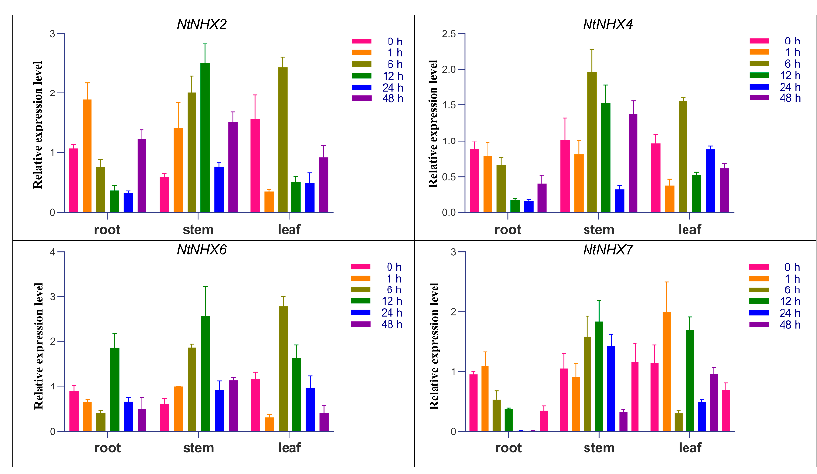
Figure 13. Relative expression level of NtNHXs in Nitraria tangutorum under 500 mM NaCl salt stress .